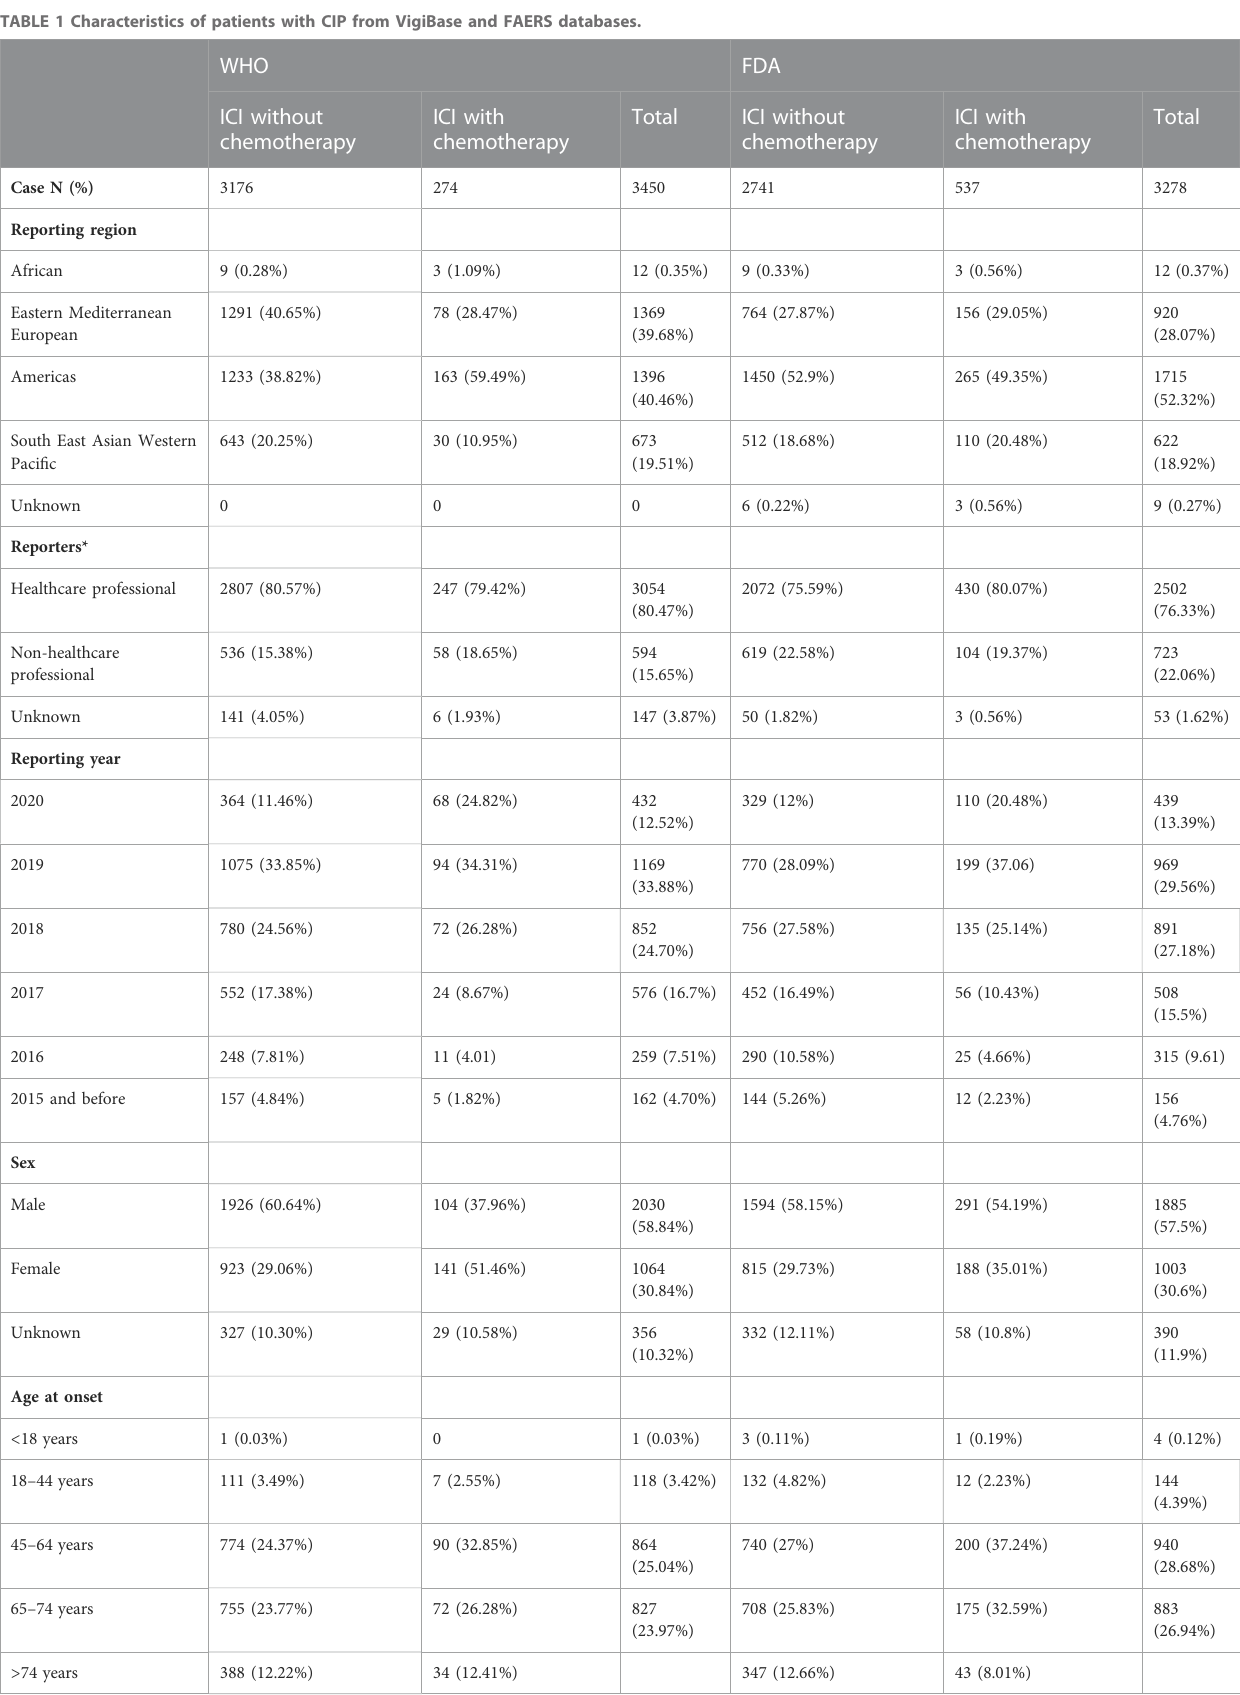
TABLE 1 Characteristics of patients with CIP from VigiBase and FAERS